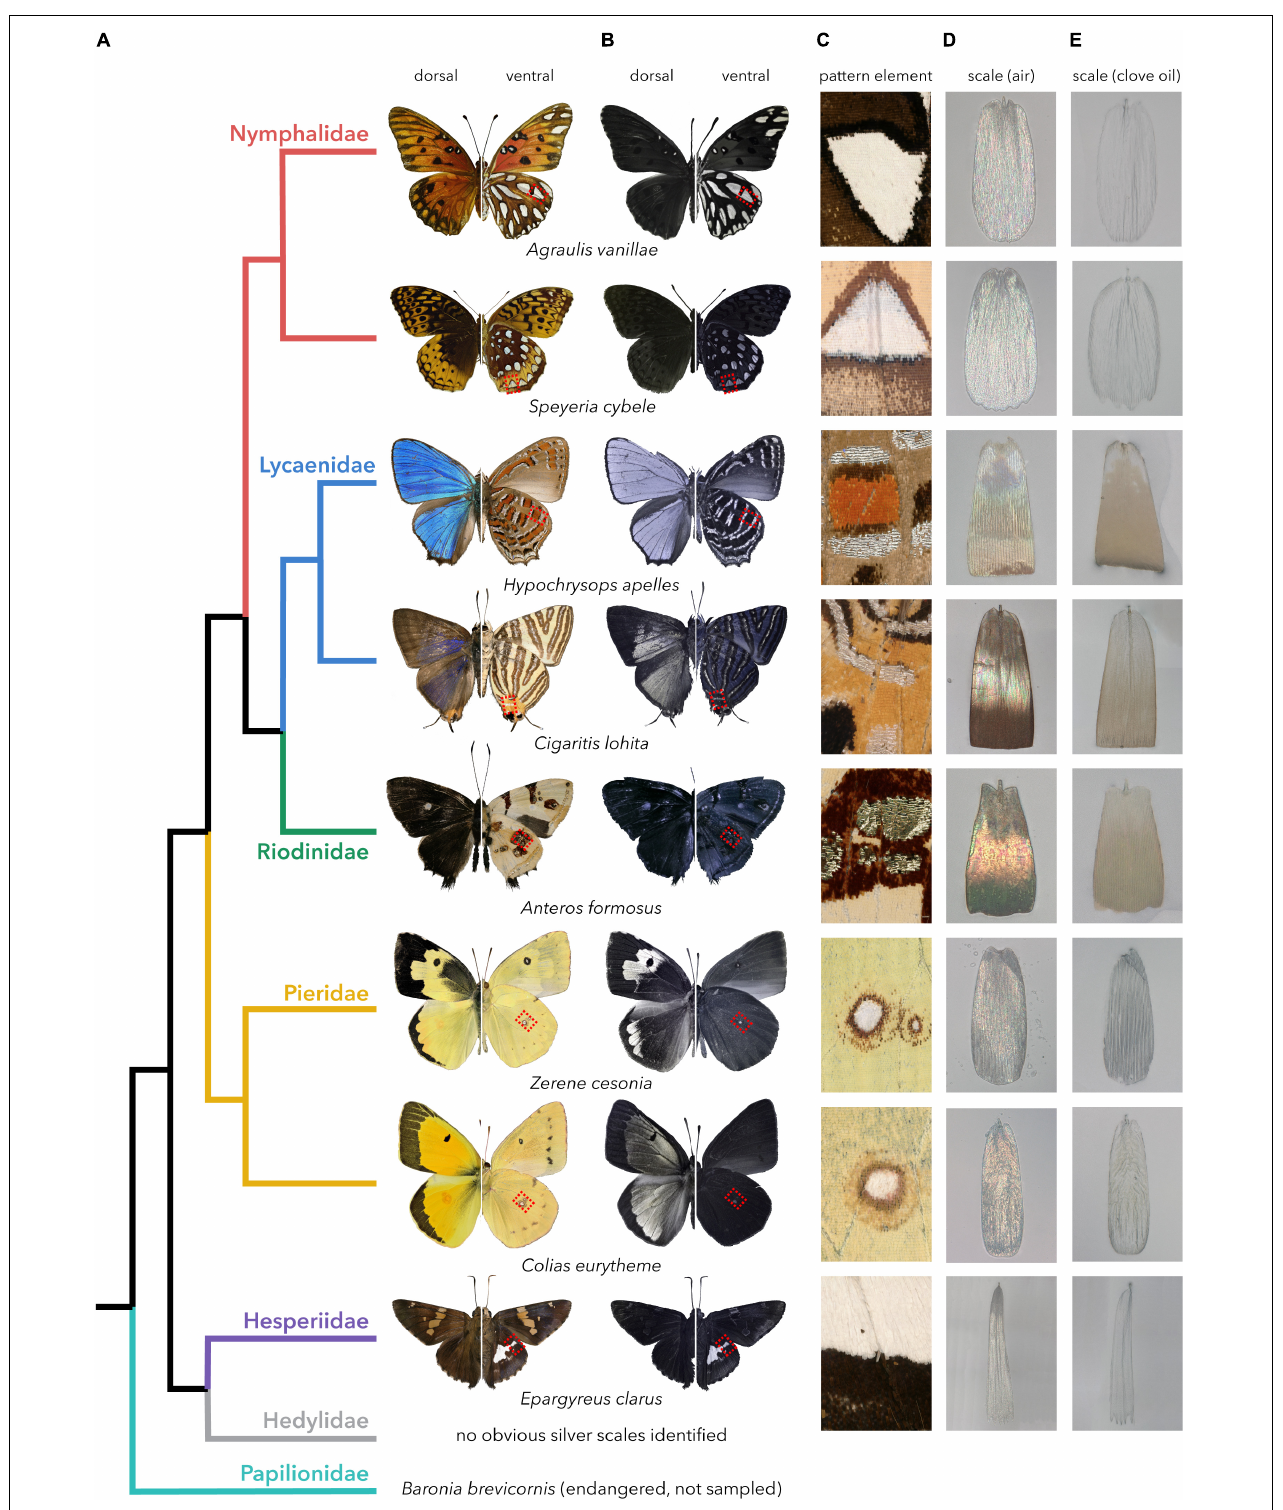
FIGURE 1 | Repeated occurrence of metallic scales in butterflies. (A) Phylogenetic relationships between the eight species sampled in this study (Espeland et al., 2018; Wiemers et al., 2019). (B) Ultraviolet (UV-B) photographs reveal reflectance in the non-visible range. (C) Magnified views of the reflective patterns obtained by a digital microscope, corresponding to red square insets in panels (A,B) . (D,E) Reflected-light microscopy of single silver or gold scales in air ( n = 1) and transmitted-light in clove oil ( n = 1.53).